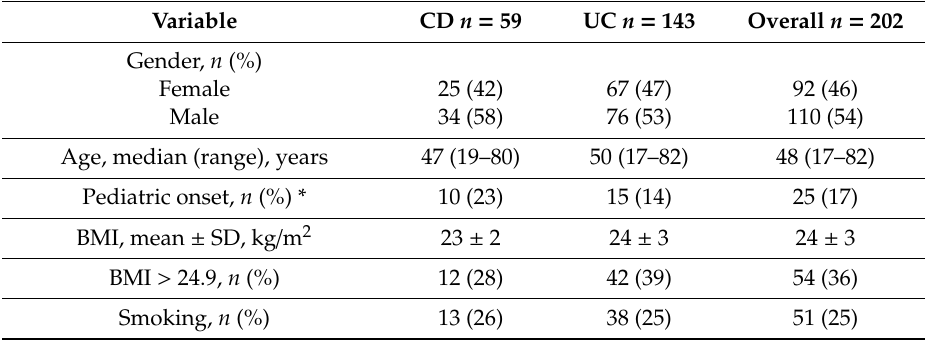
Table 1. Demographic and clinical characteristics of the 202 patients with inactive inflammatory bowel disease